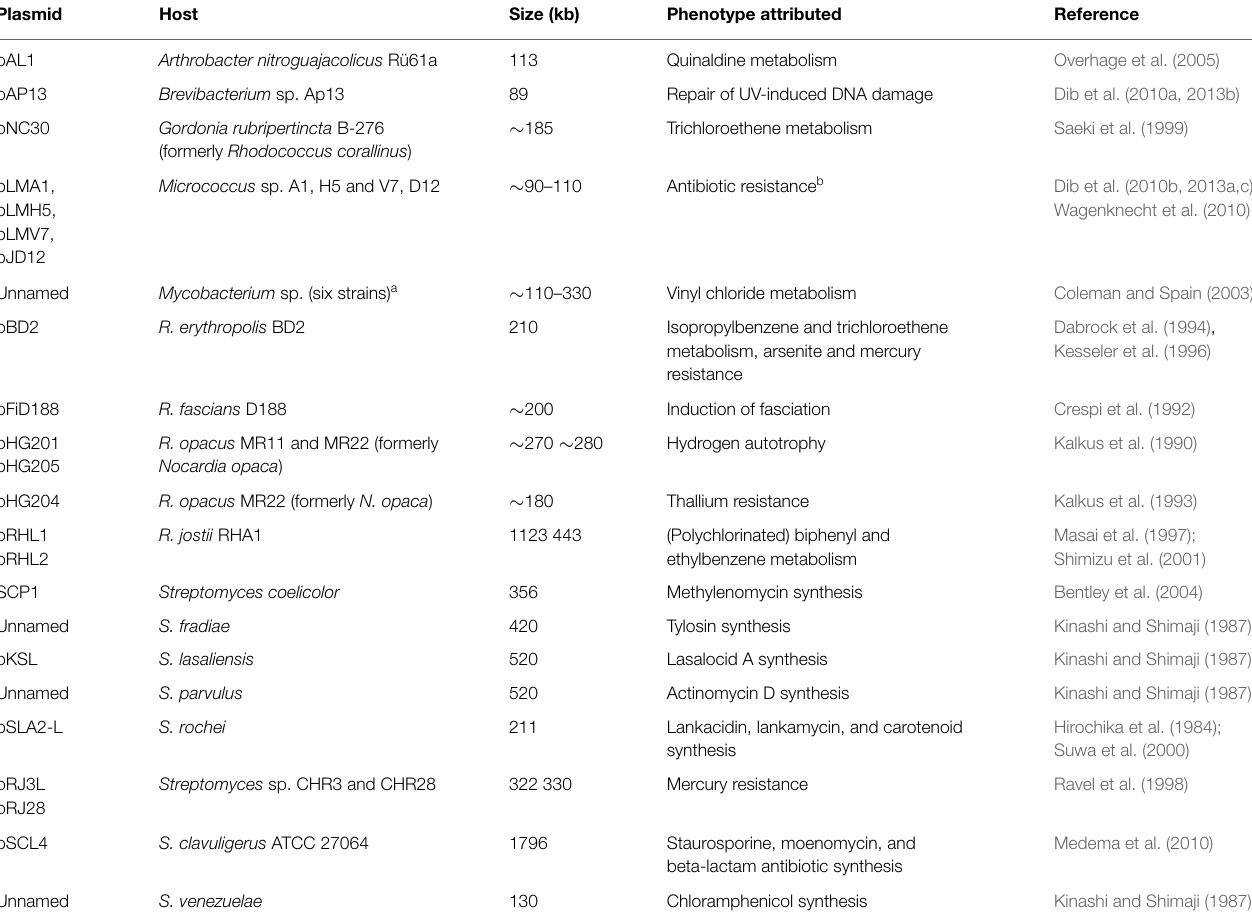
TABLE 2 | Compilation of selected actinobacterial linear plasmids and phenotypes attributed (modified after Wagenknecht, 2010).